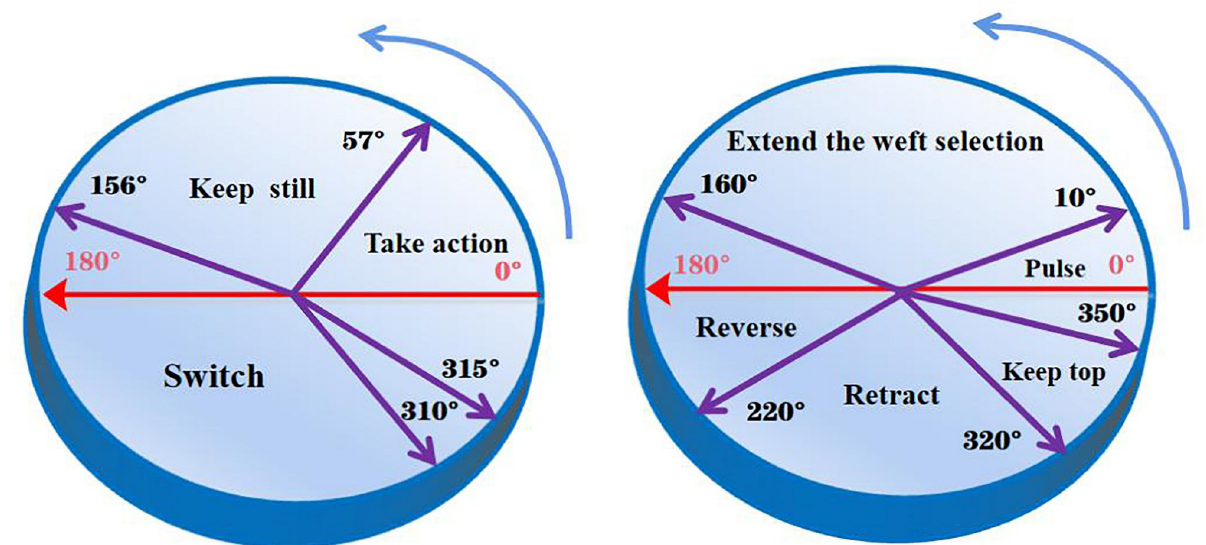
Fig 10. The corresponding action timing chart of the spindle rotation